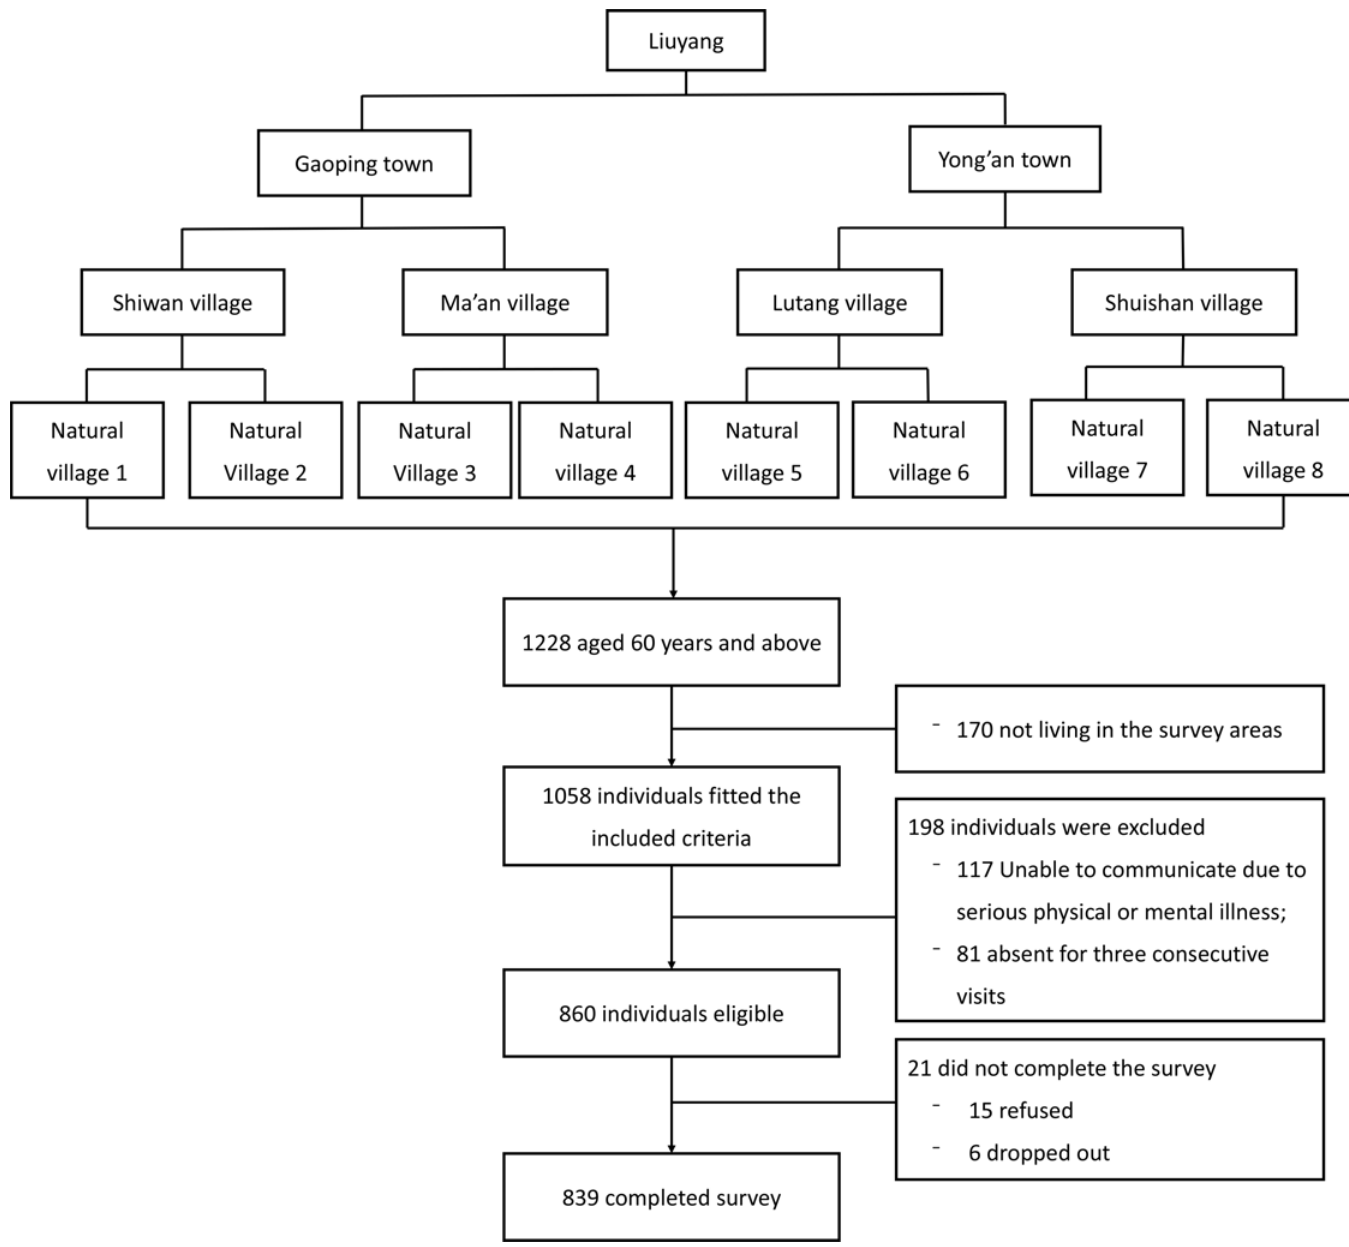
Fig 1. Flow chart of participant ’ s